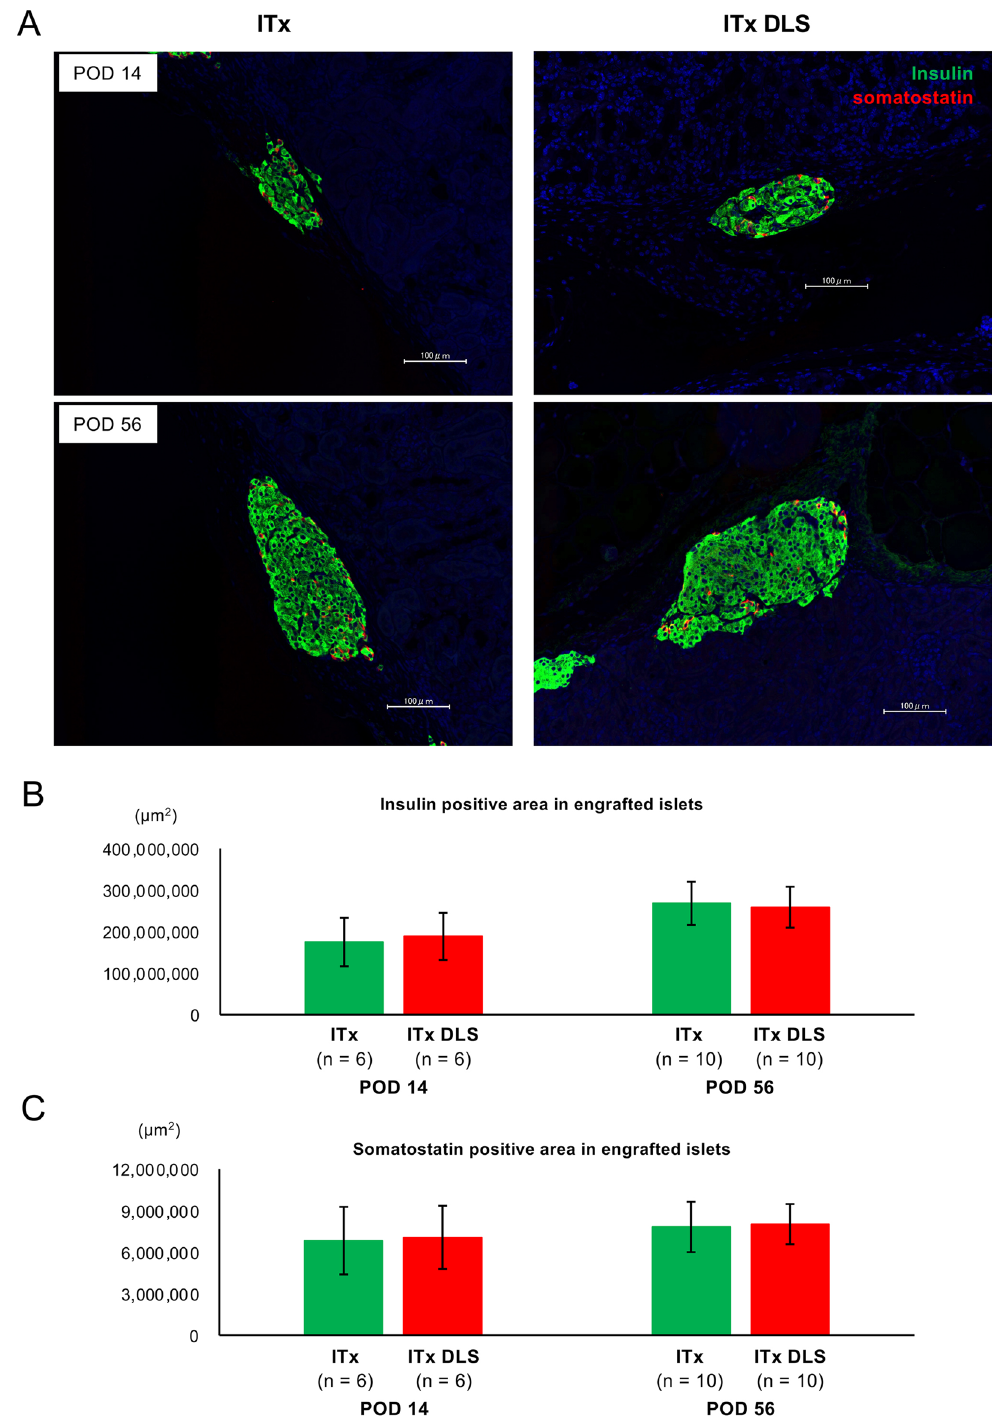
Figure 5. Histological findings of the graft in the ITx DLS and ITx groups. ( A ) Histological findings of transplanted islets in the renal subcapsular space of the ITx DLS and ITx groups at PODs 14 ( upper ) and 56 ( lower ) stained for insulin ( green ) and somatostatin ( red ). Nuclei were stained using DAPI ( blue ). ( B ) Insulin- positive area in engrafted islets. ( C ) Somatostatin-positive area in engrafted islets. Data are presented as means ± SEMs. P value < 0.05 was considered statistically